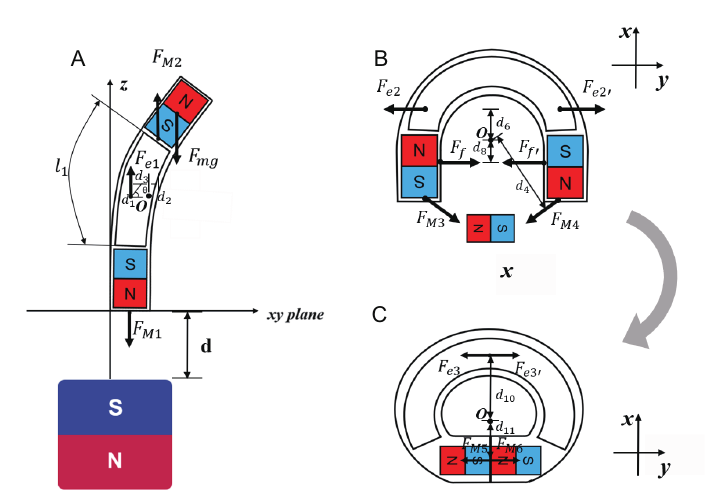
Figure 2. Physical analysis of MHCMM in three force states (lateral view). ( A ) Standing at one end; ( B ) leading the attraction process at both ends; ( C ) knotting into a